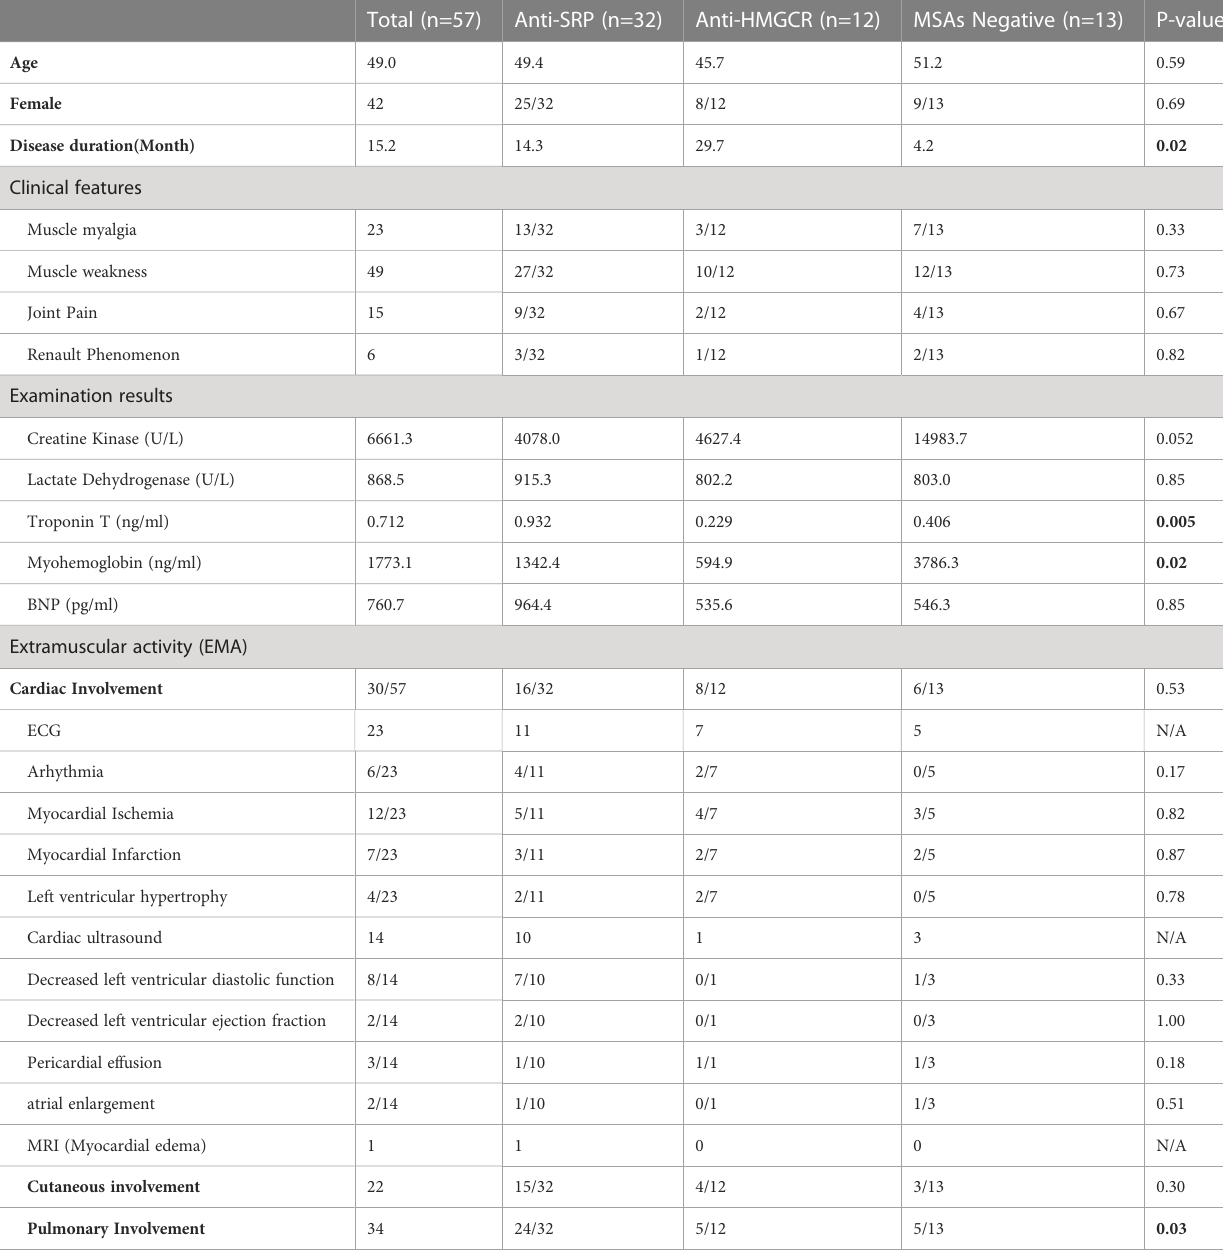
TABLE 1 Demographic and clinical characteristics of different MSA types in IMNM.